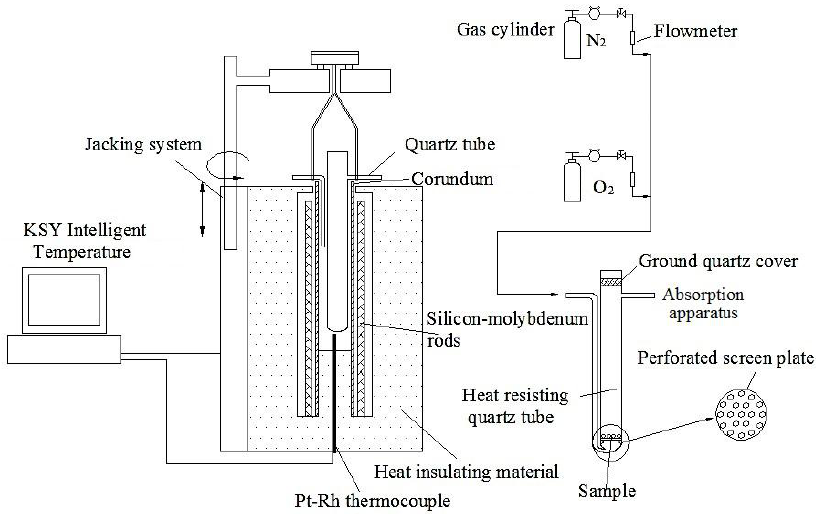
Figure 2. Schematic diagram of the equipment for